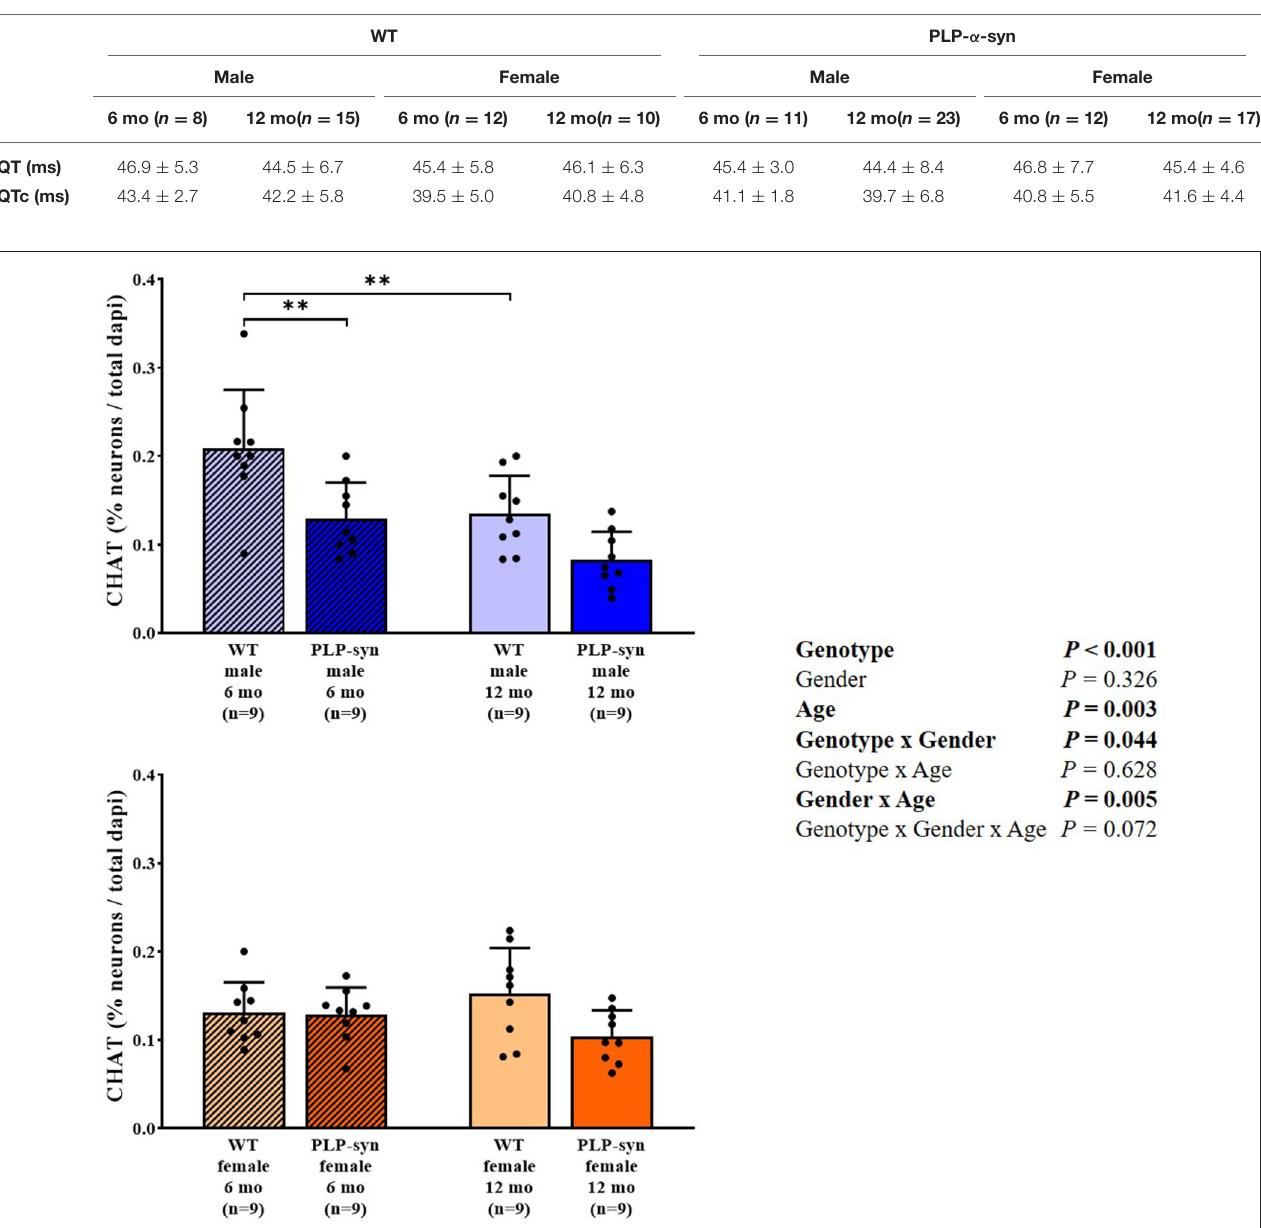
TABLE 1 | QT and QTc data.